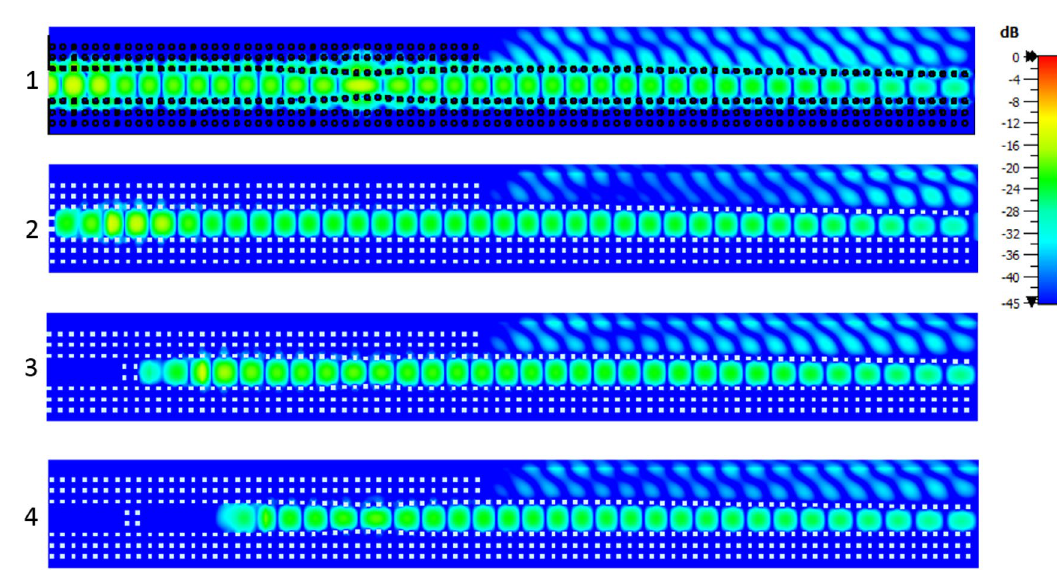
Figure 10. Amplitude distribution of the electric field of the proposed array shown separately for the four different elements. The bottom element is denoted as “1” and the top element of the stacked array is denoted as